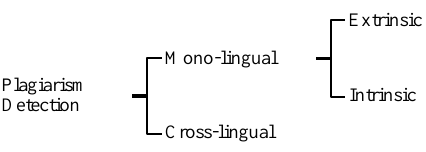
Figure 2. Plagiarism detection